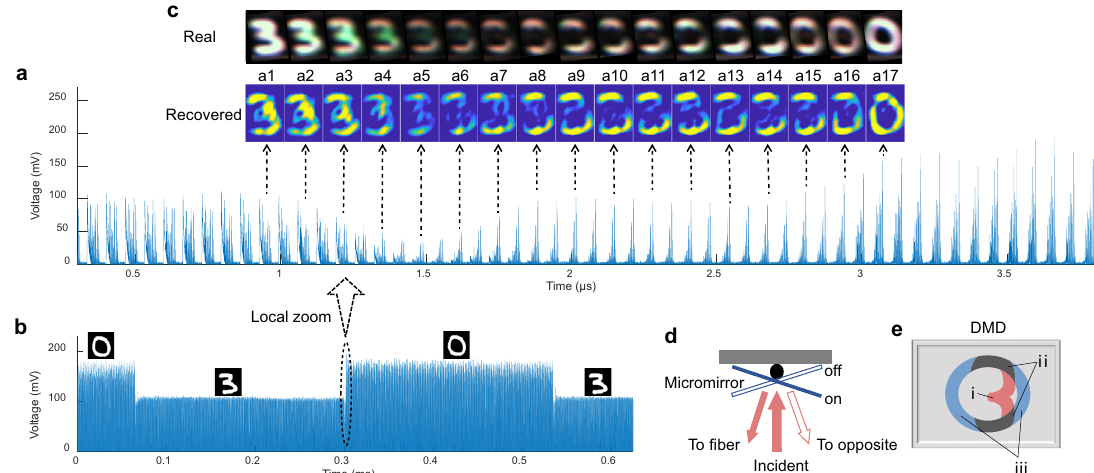
Fig. 6 Ultra-high-speed imaging. a Waveforms collected during the transient time when the DMD refreshes from an image 3 to an image 0. Insets (a1 – a17) show the images reconstructed from some of these waveforms. b Waveforms recorded with the DMD periodically displaying two images, from which we see that each image has an exposure time of 235 μ s, which is used by the DMD to load the data of the next image into the memory cells beneath the pixels. After all data have been loaded, the DMD switches to the other image within only 3 μ s, as marked by the dashed circle. The details of this region are shown in ( a ). c Real images of the DMD captured during the refresh process using a commercial high-speed camera. d Structure of one pixel of the DMD. A DMD chip has many micromirrors on its surface, which correspond to the pixels in the image to be displayed. These micromirrors can be individually rotated by approximately ±12° to an on or off state. In the on state, the illumination light is re fl ected back to the fi ber probe. In the off state, the light is directed in another direction. Thus, the array of micromirrors can produce intensity modulations on the light fi eld. When the DMD refreshes its current image, all micromirrors move to their assigned states at the same moment. e Schematic of the patterns of digits 3 and 0 displayed on the DMD chip. When the DMD switches from 3 to 0, the micromirrors in the overlapping region of the two patterns (region ii) do not change their states, while those in regions (i) and (iii) rotate in the opposite